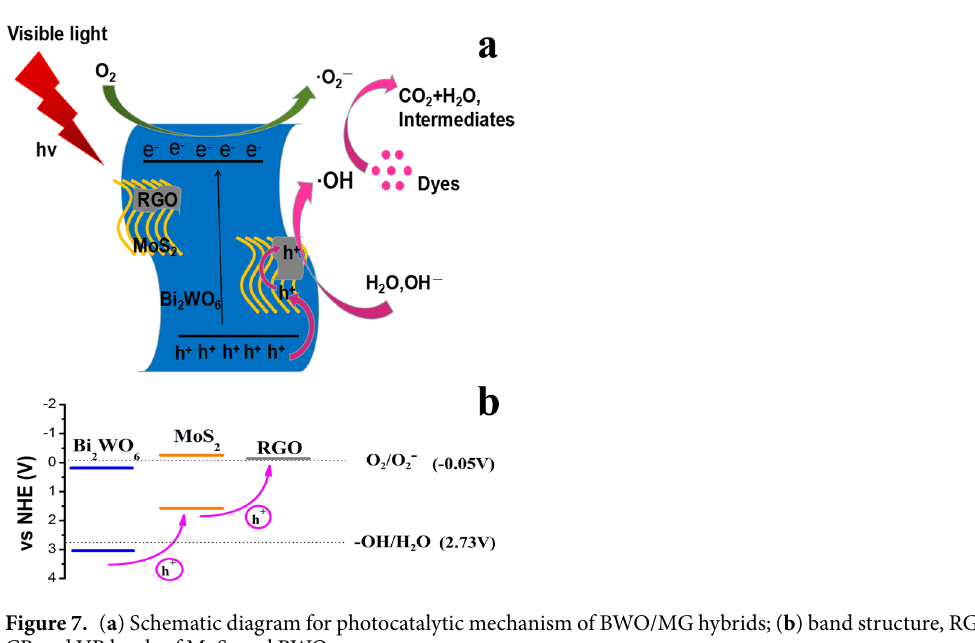
Figure 6. N 2 adsorption/desorption isotherms of ( a ) pure BWO, ( b ) MG and ( c ) BWO/MG nanoparticles.